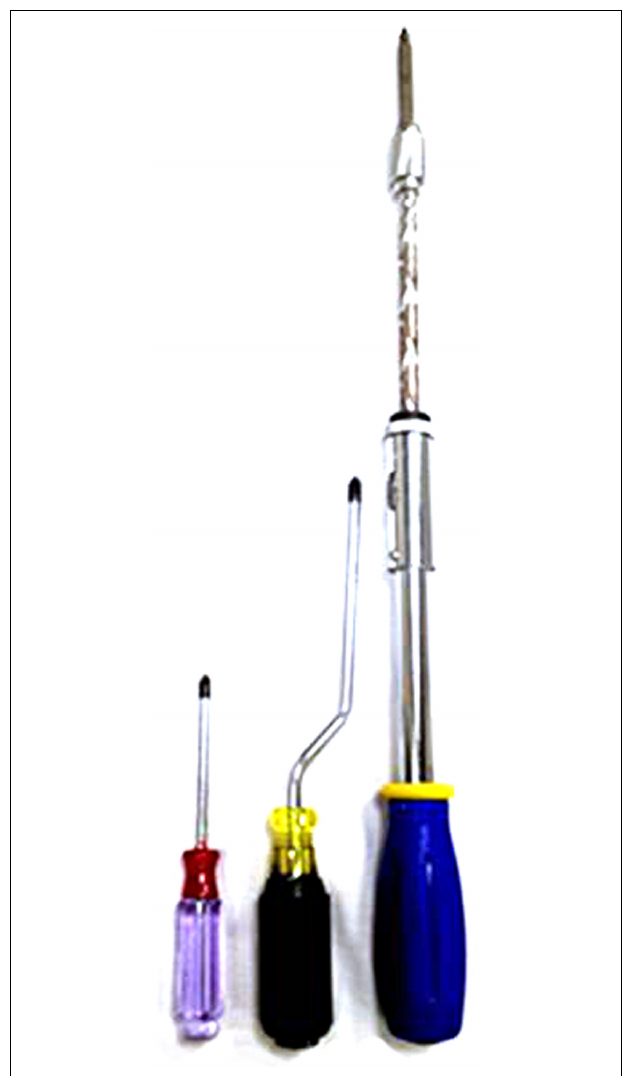
FIGURE 2 |A familiar twist screwdriver, a rotational (plumbers’) screwdriver, and a “Yankee” push screwdriver (from left to